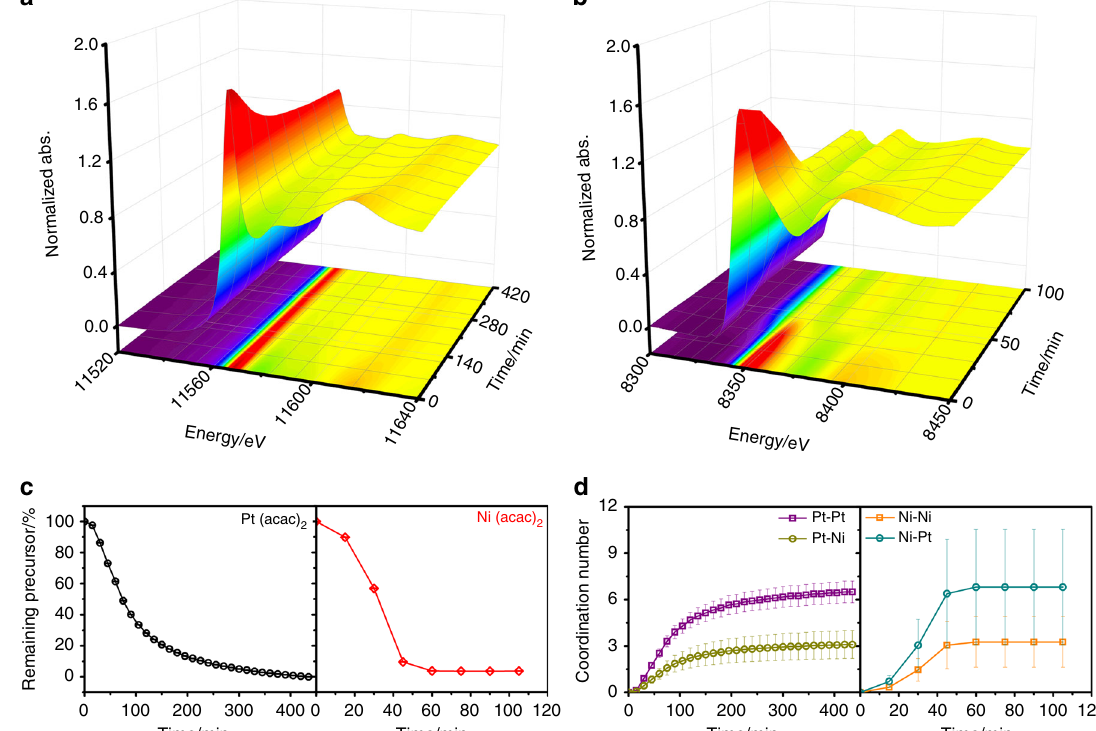
Fig. 3 Overall composition changes of the growing particles. a Pt L 3 -edge and b Ni K-edge XAS spectra of the growing nanoparticles. c Percentage of remaining precursors calculated from the XAS data and d coordination numbers of the reduced elements calculated from the XAS data as function of reaction time (Error bars correspond to fi tting errors of XAS data